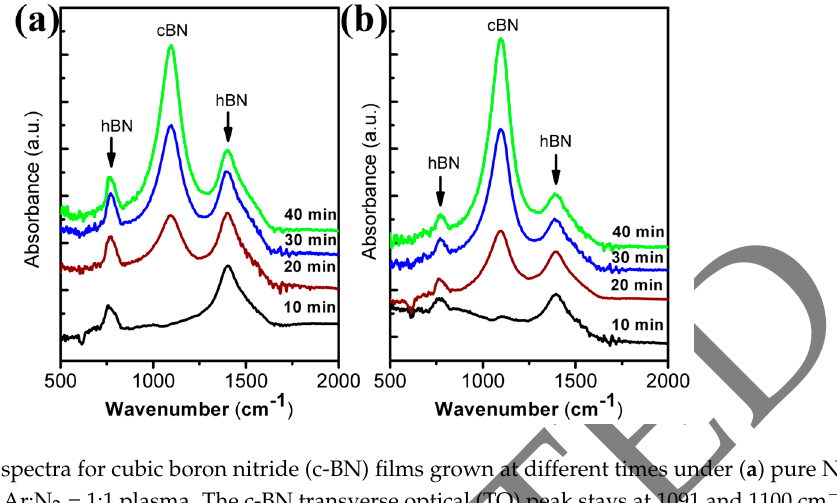
Figure 1. FTIR spectra for cubic boron nitride (c-BN) films grown at different times under ( a ) pure N 2 plasma and ( b ) Ar:N 2 = 1:1 plasma. The c-BN transverse optical (TO) peak stays at 1091 and 1100 cm − 1 in the two-gas system.